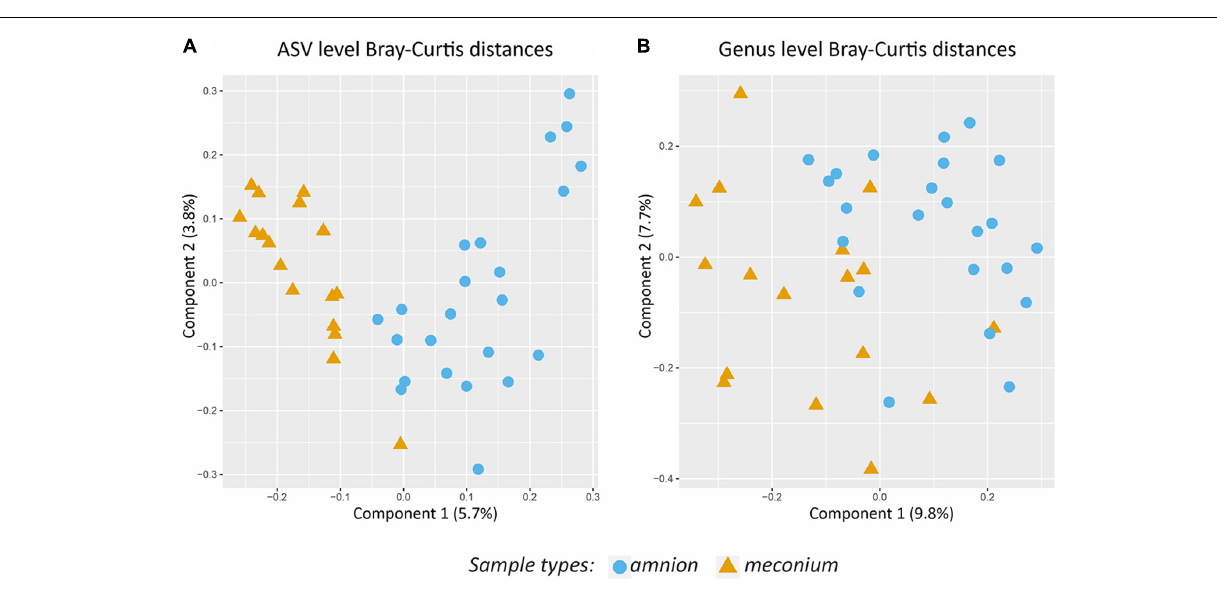
FIGURE 5 | Comparison of the bacterial community structure of amniotic fluid and meconium. (A) PCoA on Bray-Curtis distances based on ASV level data. (B) PCoA on Bray- Curtis distances based on genus level data. Colors and shapes indicate the sample